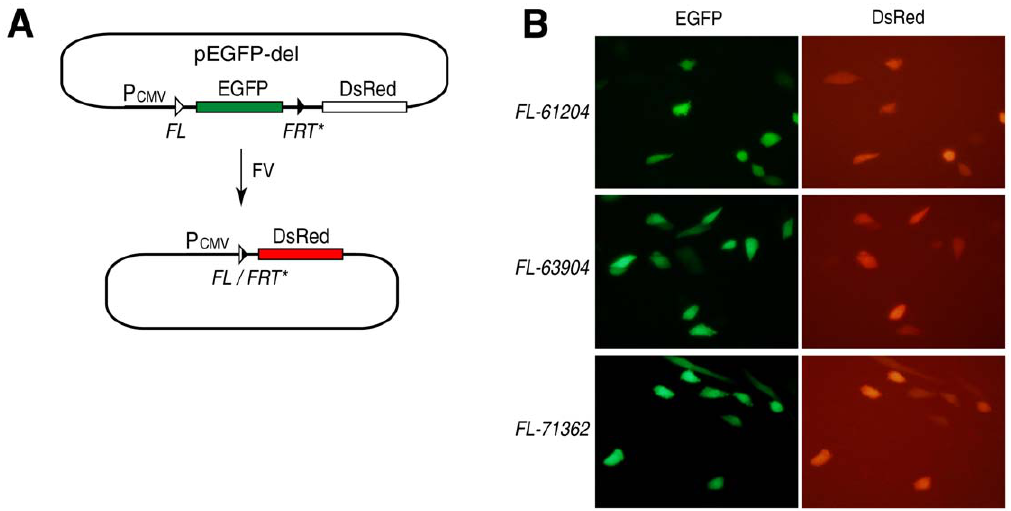
Figure 2. Evolved variants of Flp recombinase are active in mammalian cells. (A) Schematics of the deletion assay used to test Flp variants in CHO cells. An episomal reporter pEGFP-del bears the EGFP expressing cassette followed by a promoterless DsRed gene. The EGFP gene is flanked by two recombination sites: genomic FRT -like sequence (either FL-61204 , FL-63904 , or FL-71362 ; these sites are shown as ‘ FL ’) and modified FRT (shown as FRT *), in which its native spacer was substituted with the spacer from the respective FRT -like sequence. The choice of genomic FRT -like sequences and modified FRT as recombination partners for the evolved Flp variants was suggested by the results of our earlier experiments with Flp variant FV7 which showed that this combination of recombination sites works the best in the excision assay [14]. ( B) Evolved Flp variants efficiently recombine their respective FRT -like sequences in CHO cells.